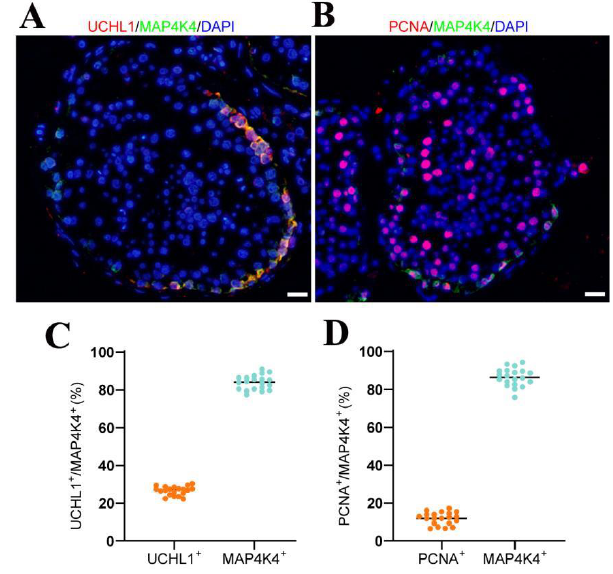
Figure 1. The expression of MAP4K4 in normal human testis. ( A , B ) Double immunostaining showed the co-expression of MAP4K4 with UCHL1 ( A ) and PCNA ( B ) in normal human testis. ( C , D ) The percentages of MAP4K4 + cells with UCHL1 ( C ) and PCNA ( D ) expression. Each dot in the graph represented the positive cells in one seminiferous tubule, and black line was the mean value. At least 20 seminiferous tubules were counted. Scale bars in A: 50 μm.